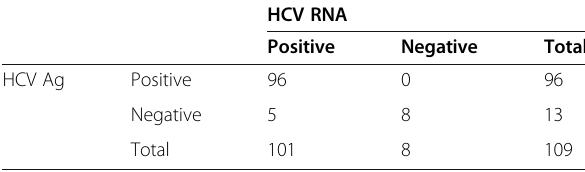
Table 1 Sensitivity and specificity of HCV Ag in predicted HCV RNA in 109 anti-HCV positive patients HCV RNA